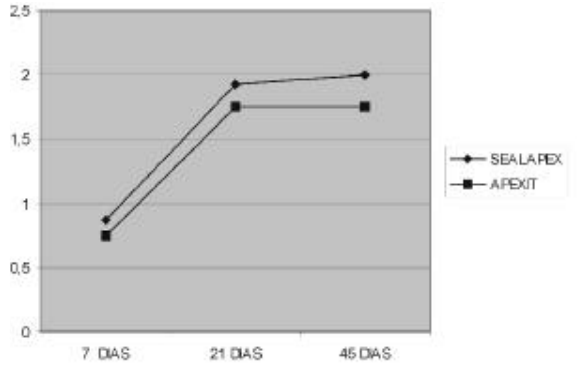
FIGURA 10 - Inter-relação dos valores de